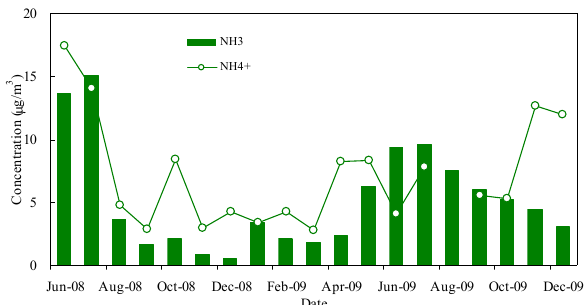
Fig. 10. Temporal variations of monthly concentrations for NH 3 Fig.10 Temporal variations of monthly concentrations for NH 3 and NH 4+ in PM 2.5 at SDZ from June and NH + in PM 2 . 5 at SDZ from June 2008 to December 2009. 2008 to December 2009. 4